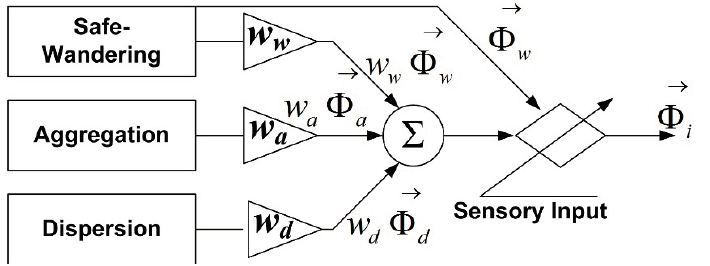
Figure 6. The combination of the basic